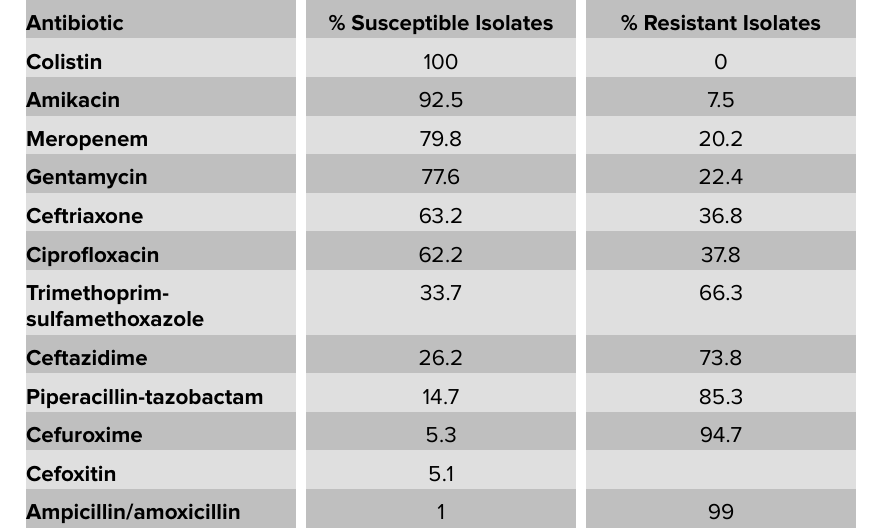
Table 2: Antibiotic susceptibility pattern among Gram-negative